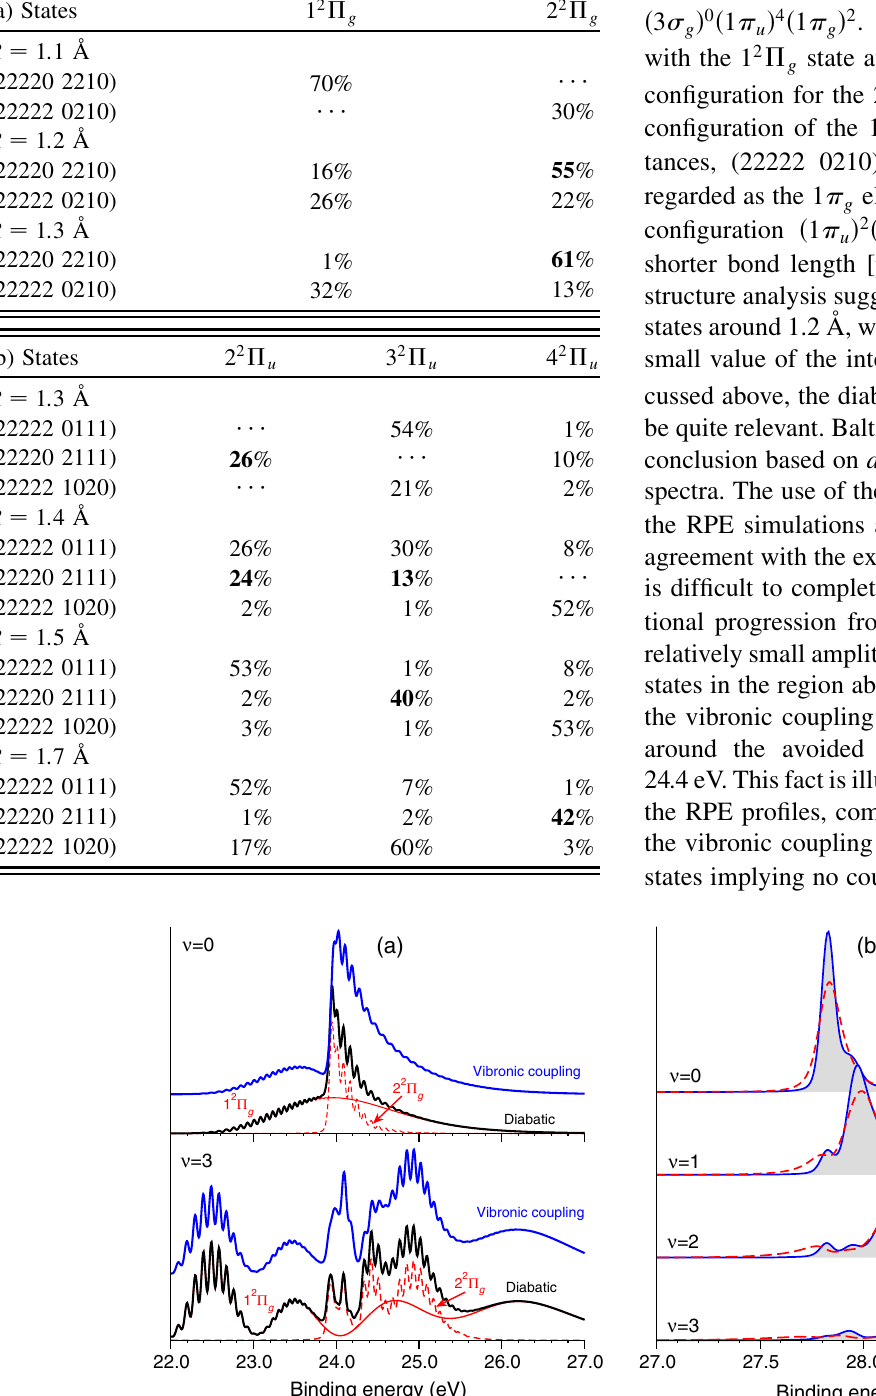
and 2 2 (cid:2) states compared to the calculations that take into account the vibronic g g states computed using the diabatic (shaded areas) and u